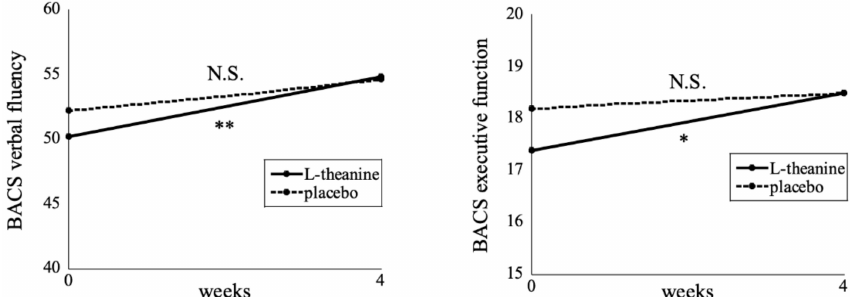
Figure 2. Cognitive function scores after 4 weeks L-theanine or placebo administration. The Wilcoxon signed-rank test revealed that the Brief Assessment of Cognition in Schizophrenia (BACS) verbal fluency and executive function scores were significantly decreased in the L-theanine administration ( n = 30), while there was no significant change in the placebo administration ( n = 30). * p < 0.05, ** p < 0.01. N.S.: Not